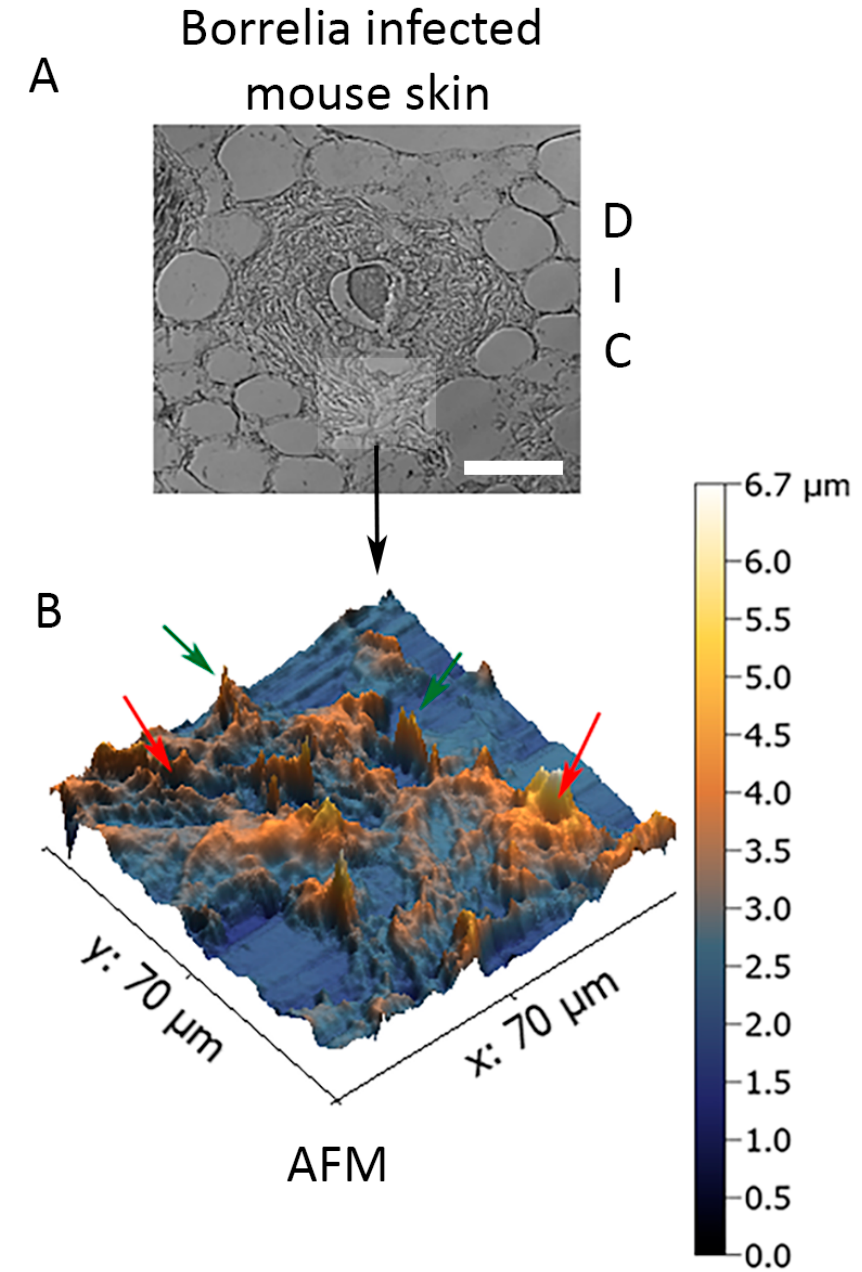
Figure 6. Three-dimensional analysis of biofilm form of B. burgdorferi via atomic force microscopy (AFM) in infected biopsies inoculated with 1 × 10 7 spirochetes and cultured in BSK-H + 6% RS medium for two weeks. Panel ( A ) shows the DIC image of the infected mouse tissue section, which was used for the AFM study (scale bar shows 100 μ m). Panel ( B ) shows the results of the AFM analyses. Red arrows show biofilm channels while green arrows show biofilm protrusions.